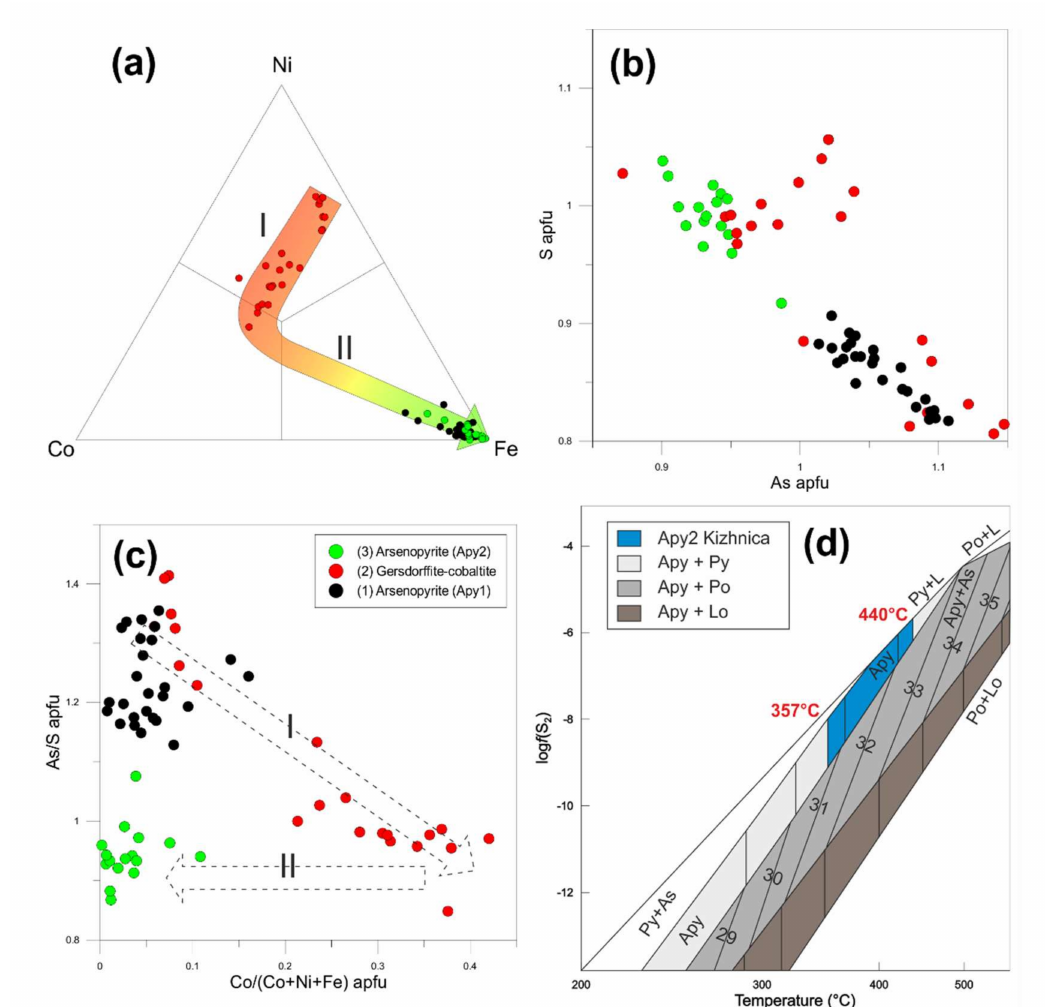
Figure 19. Plots showing the chemical composition of sulfarsenides from the Kizhnica hornfels: ( a ) ternary Ni-Co-Fe diagram; ( b ) binary S vs. As (apfu) plot; ( c ) binary As/S vs Co/(Co + Ni+ Fe) plot; ( d ) activity of log f (S 2 ) and temperature projection of the stability field of arsenopyrite (Apy2) from Kizhnica hornfels after